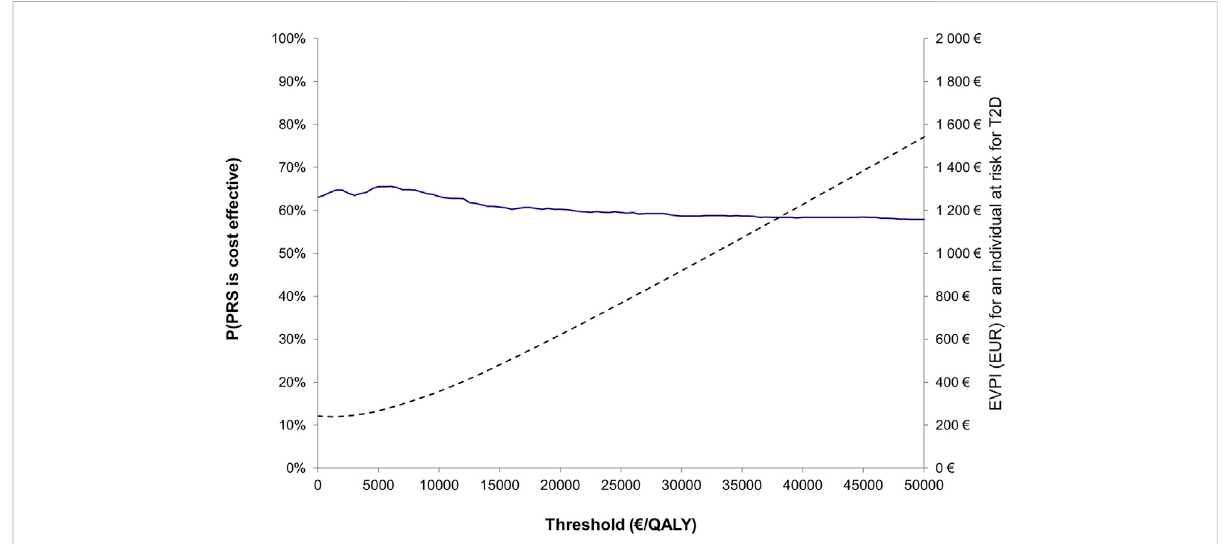
FIGURE 2 Cost-effectiveness acceptability curve (blue line; left y-axis) showing the probability that the PRS strategy is cost-effective compared to the usual practice, together with expected value of perfect information (dotted line; right y-axis) over a range of values for